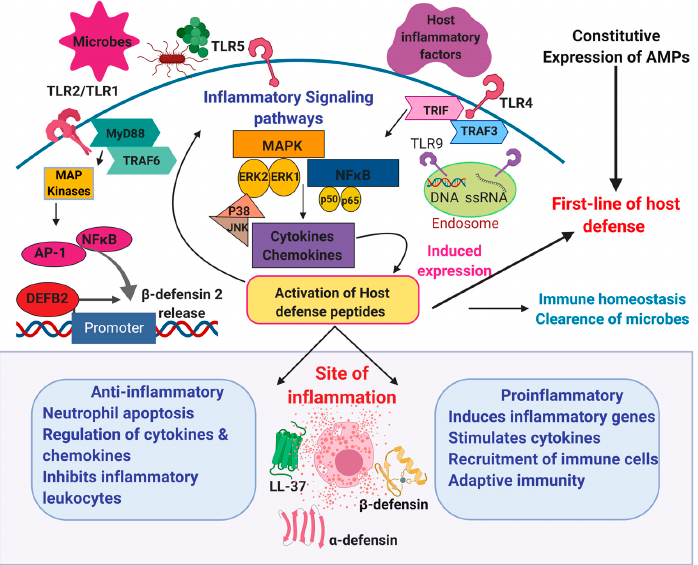
Figure 1. Illustration of the distinct role of host defense peptides at the sites of inflammation. Specific Toll-like receptors TLR-2, TLR-4, TLR-5, and TLR-6 are expressed on the plasma membrane of immune cells, non-immune cells, and intracellular compartments. TLR-7 and TLR-9 within endosomes participate in the host recognition of microbial cellular components and bind to host internal factors. The receptors, along with their adaptor proteins MyD88 and TRIF, can initiate the inflammatory signaling pathways. The host defense peptides promote innate immunity against various pathogens and maintain the immune system homeostasis. These peptides can also be induced in addition to their constitutive expression by the transcriptional modulatory factors NF- κ B, AP-1, and intracellular release